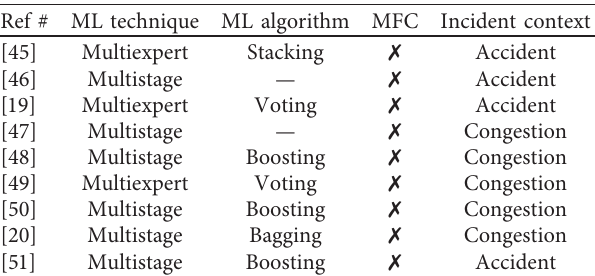
Table 4: Summary of fusion algorithm-based incident detection